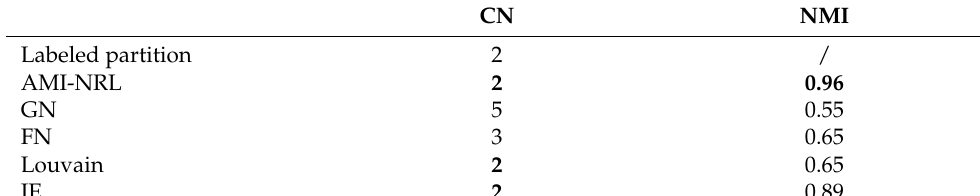
Table 3. Results of AMI-NRL and the other community detection algorithms on Dolphins.